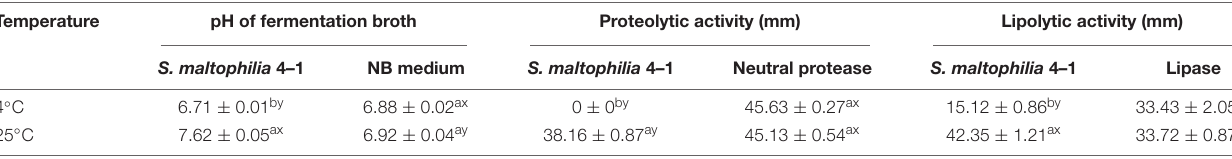
TABLE 1 | The spoilage potential of S. maltophilia 4–1 at 4 and 25 ◦ C.